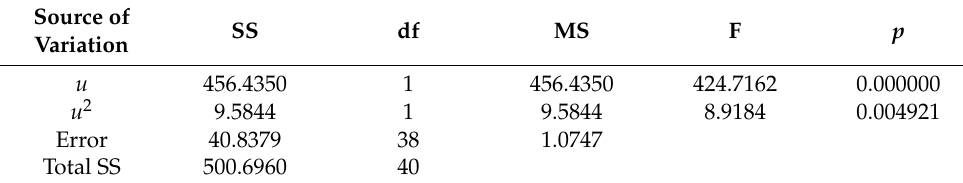
Table 11. Model of hardness H— ANOVA table, R 2 = 0.92; R adj2 = 0.91. Source of